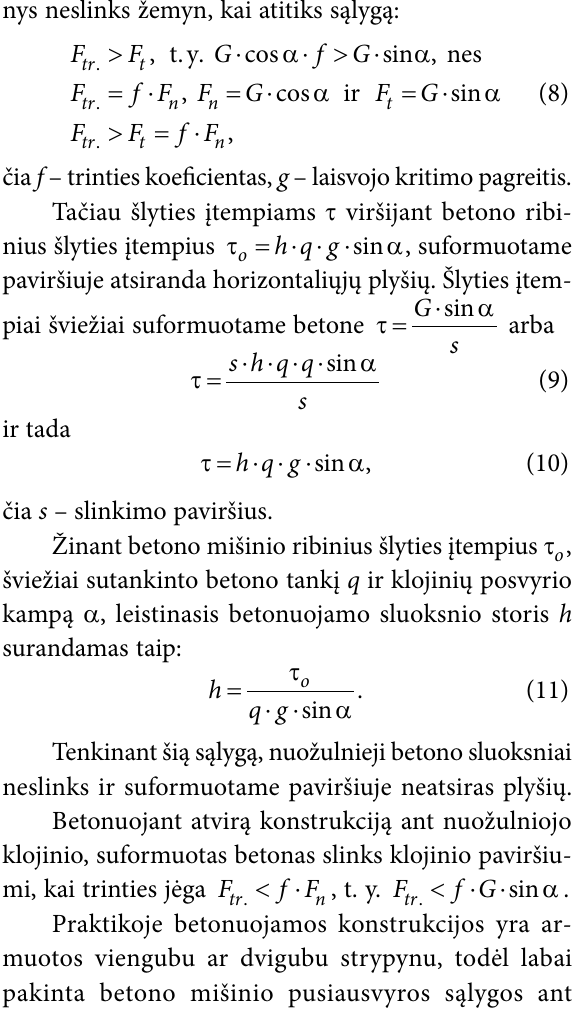
Fig. 3. Stress diagram